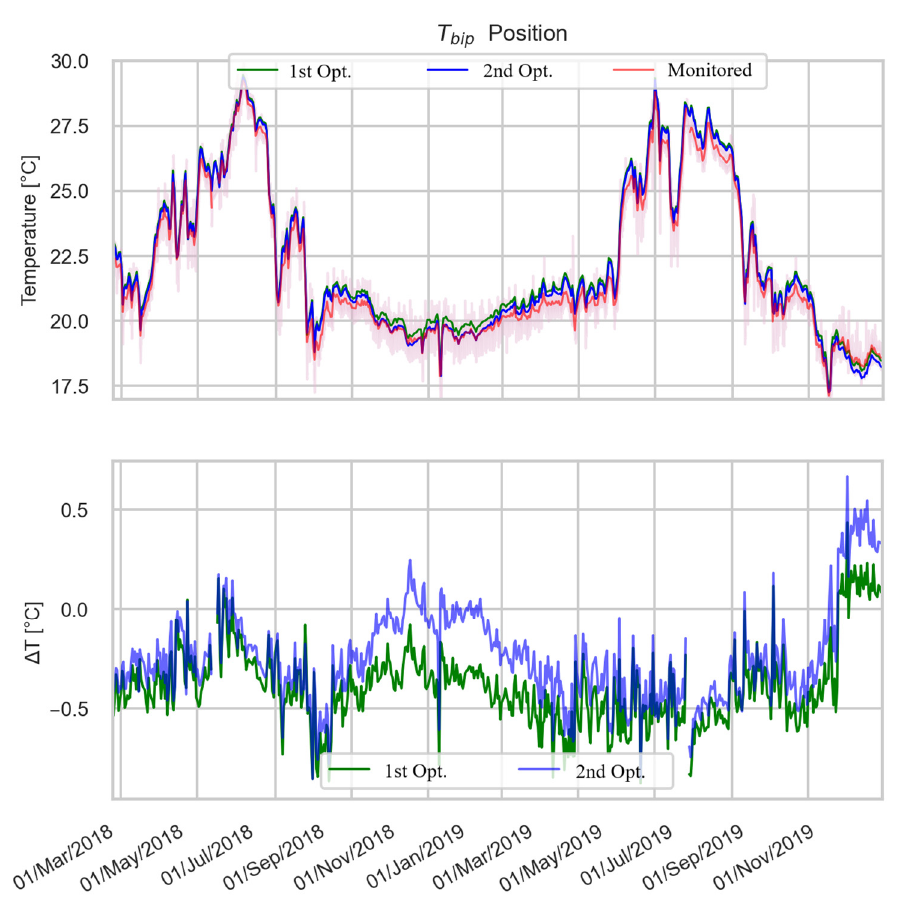
Figure 10. Comparison of the curve of the monitored temperature values at position T bip (in red including the shadow air of the measurement uncertainty) with the curve of the first optimized simulation (in green) and the second optimized simulation (blue).